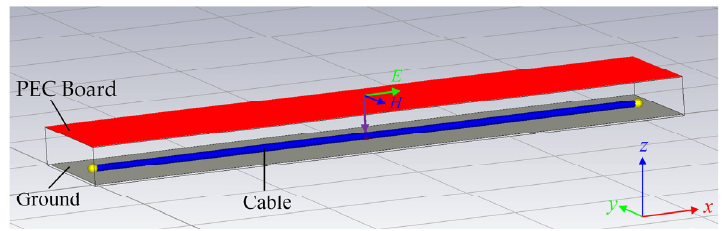
Figure 3. Simulation diagram of secondary cable radiation disturbance.